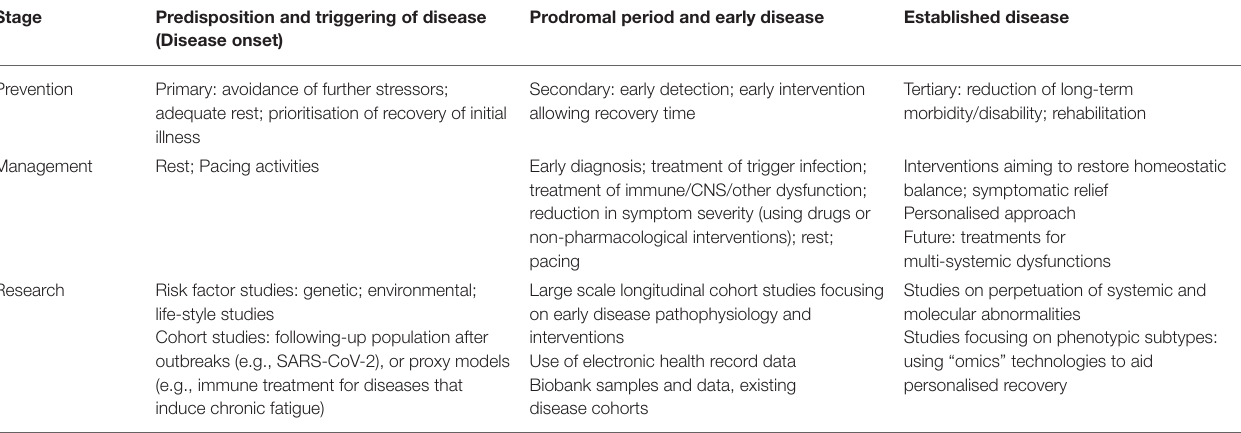
TABLE 2 | Summary of prevention, management and research strategies for ME/CFS according to stage of disease.